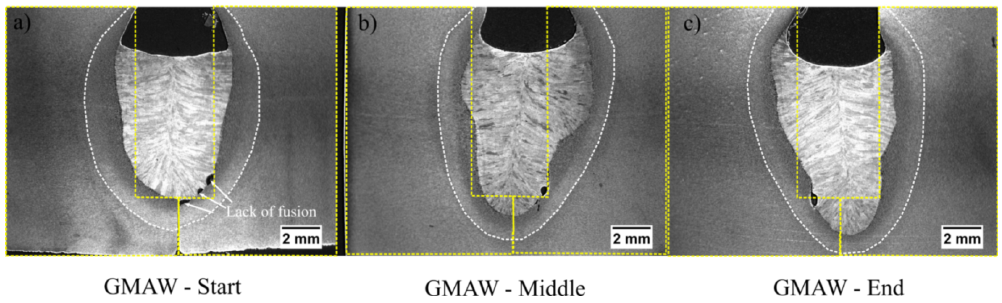
Figure 8. Root pass macrographs for the standard GMAW process: ( a ) start of the joint; ( b ) middle of the joint; and ( c ) end of the joint.